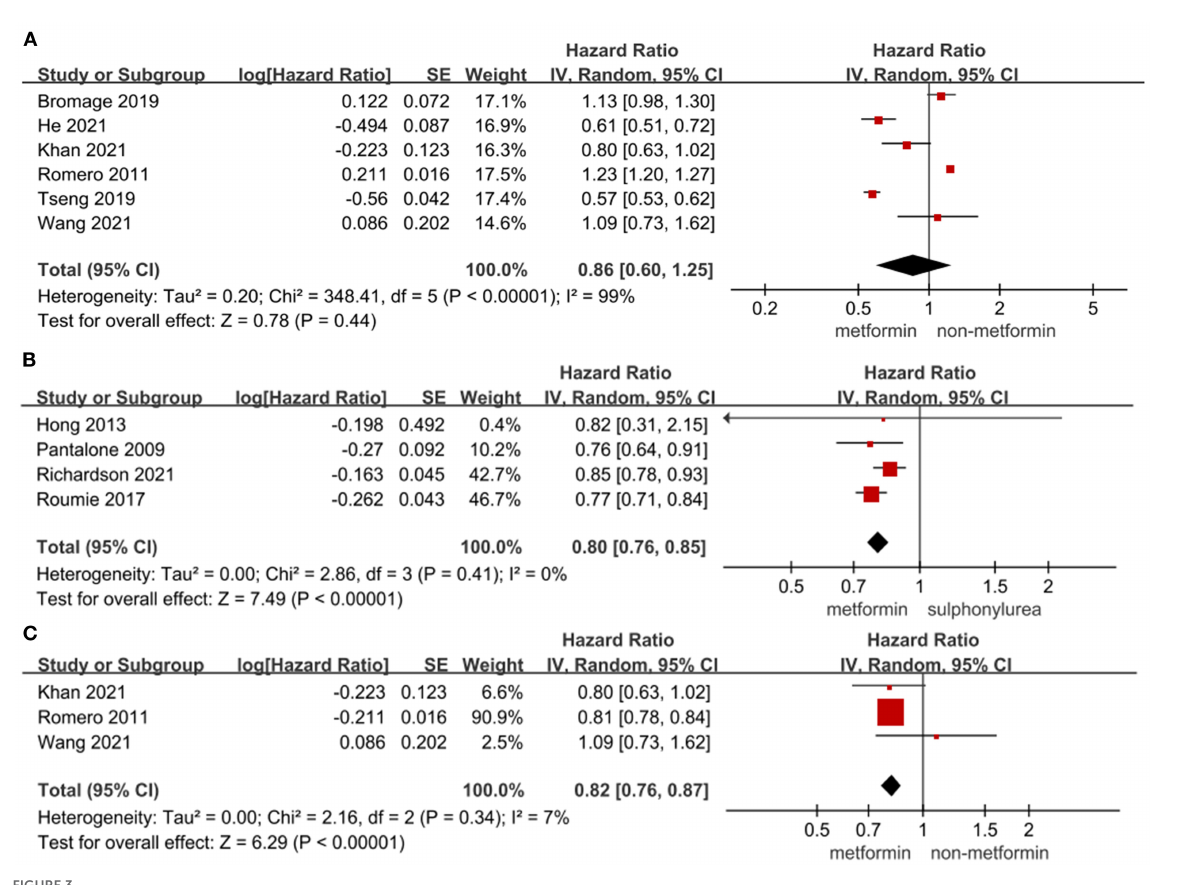
FIGURE3 (A) Forest plot of hazard ratio of heart failure among patients with metformin therapy vs non-metformin therapy. (B) Forest plot of hazard ratio of heart failure among patients with metformin therapy vs. sulphonylurea therapy. (C) Forest plot of hazard ratio of the recurrent incident of heart failure among heart failure patients with metformin therapy vs. non-metformin therapy. CI, confidence interval; SE, standard error; IV, inverse of the